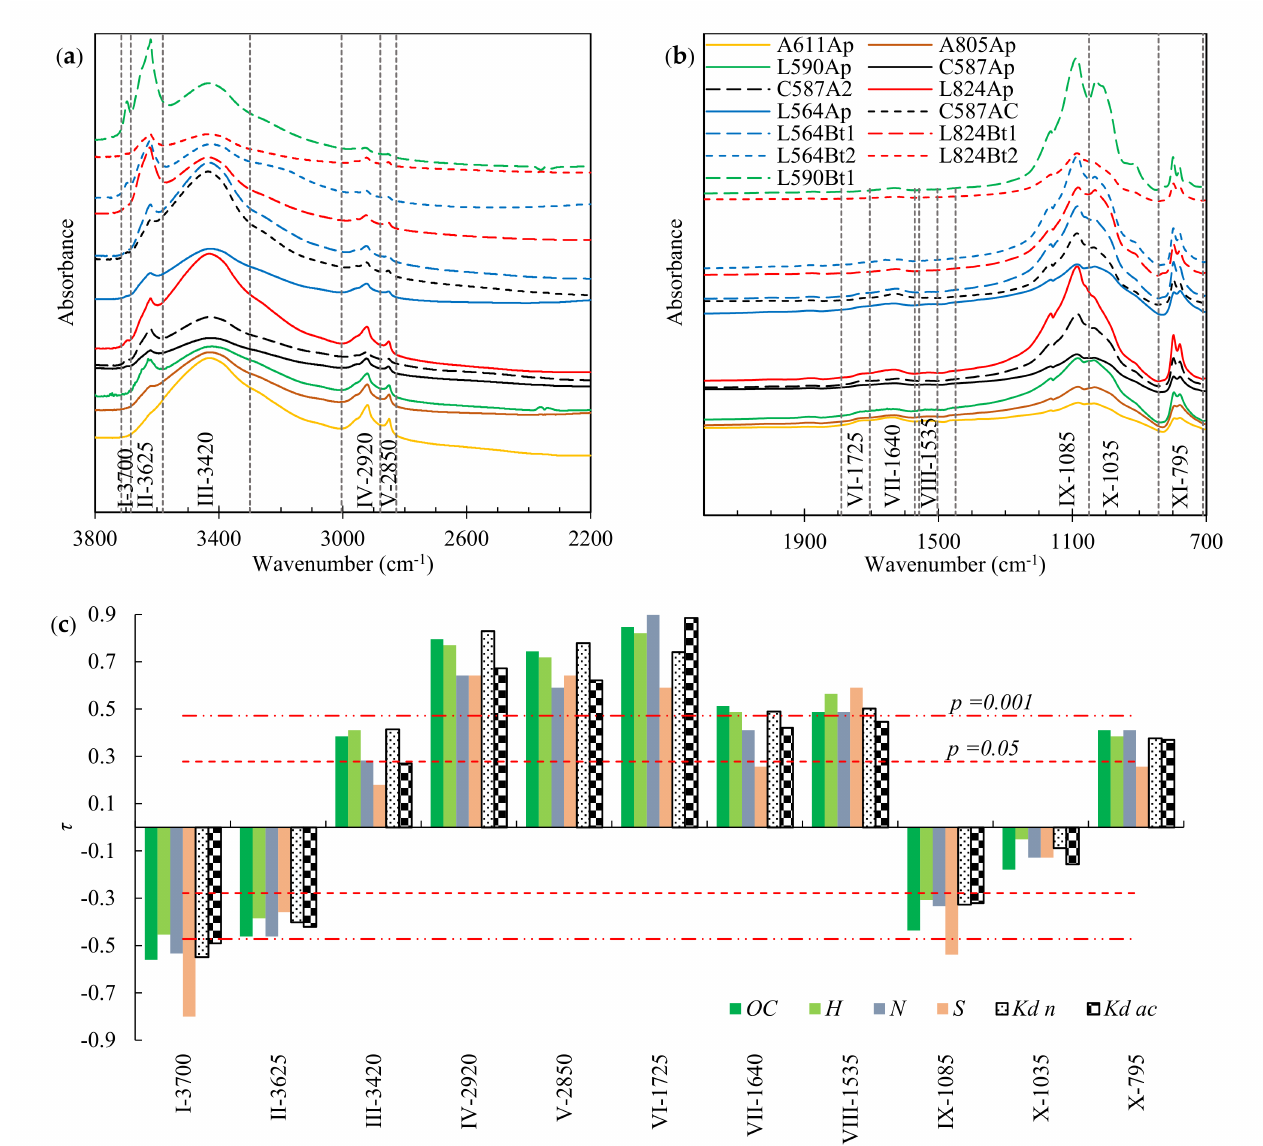
Figure 2. ( a , b ) FT-IR spectra of 13 soils altered with HF, shifted vertically to avoid overlapping and arranged in order from the largest (A611Ap) to the smallest (L824Bt2) OC contents (for details concerning soil acronyms see Section 3.1); the vertical dashed lines indicate the mean integration ranges. ( c ) Kendall’s rank correlations ( τ ) between the relative intensities of bands and OC , H , N , S , K d n , and K d ac